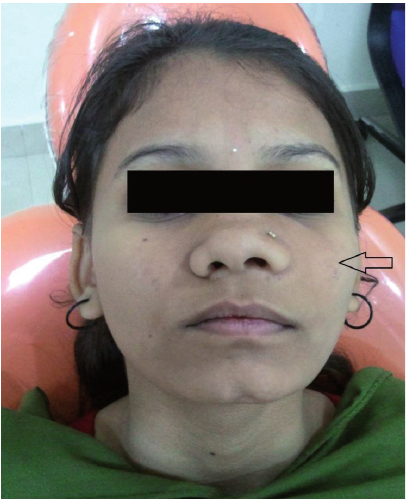
Figure 1: Preoperative frontal view showing swelling on left side of the face.